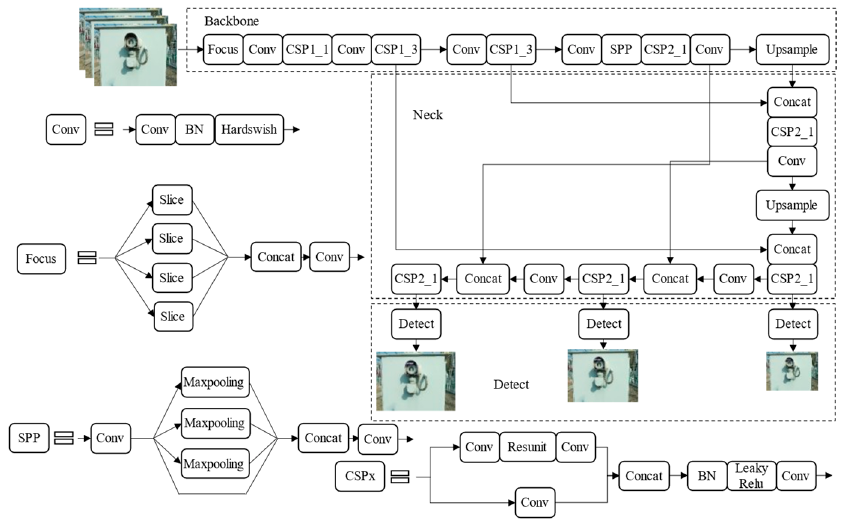
Figure 2. The YOLOv5s network structure diagram.